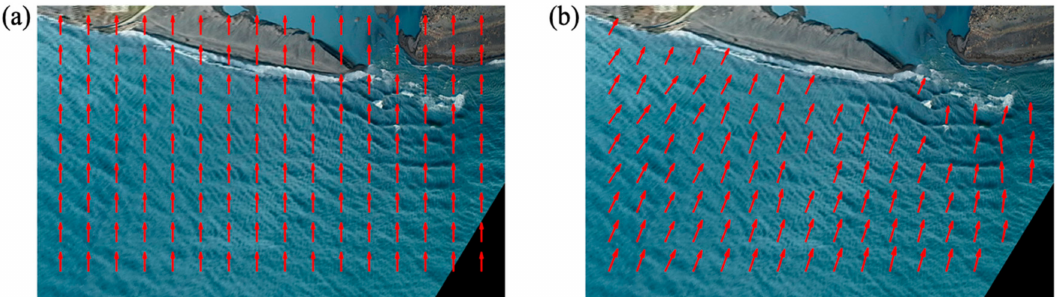
Figure 7. Computation of wave celerity vectors. ( a ) Initial estimate and ( b ) converged